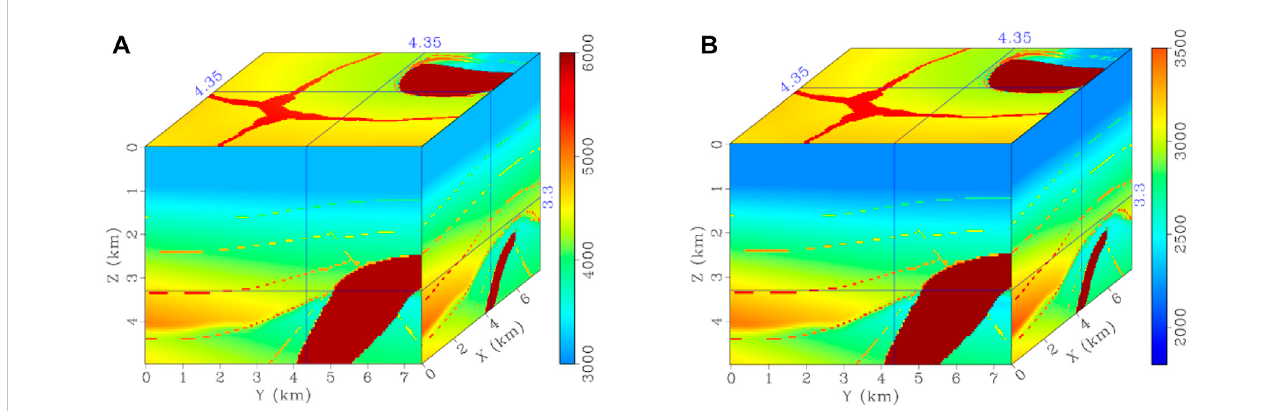
FIGURE 18 Modi fi ed salt models of (A) and (B) true P- and S-wave velocity models. Migration velocities are obtained by smoothing the true models using a 400 × 400 × 400 m smoother.